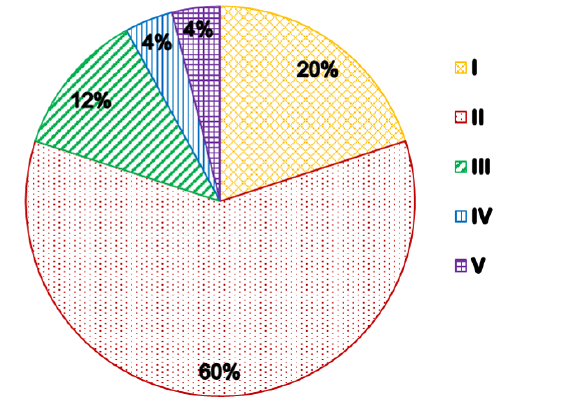
Figure 5. Percentage charts of classifications (Class I ∼ V, Table 4) of the quality of the collected groundwater